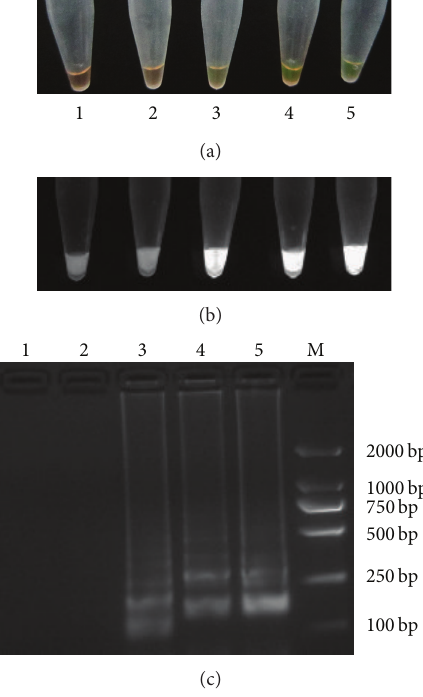
Figure 4: Sensitivity of the LAMP assay. Visual inspection in day- light (a), under UV light (b), and with 2% agarose gel electrophoresis (c). 1: negative control; 2: 10 −4 dilution; 3: 10 −3 dilution; 4: 10 −2 dilution; 5: 10 −1 dilution; M: DL2000 DNA